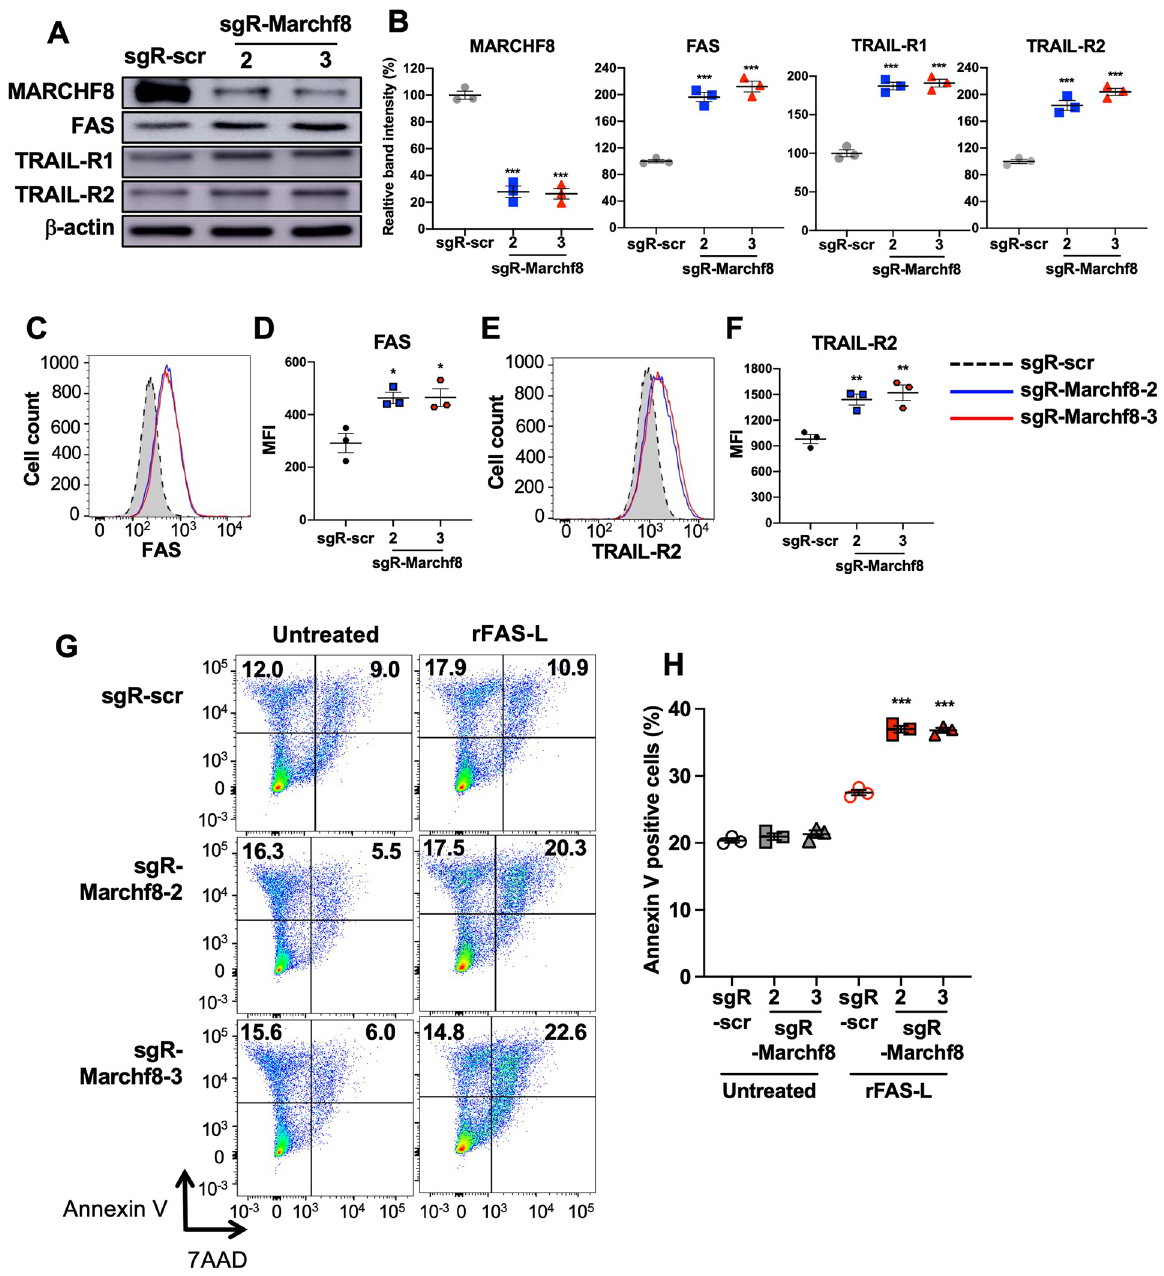
Fig 8. Knockout of Marchf8 expression increases FAS, TRAIL-R1, and TRAIL-R2 protein levels and enhances apoptosis of HPV+ mouse oral cancer cells. mEERL cells were transduced with lentiviral Cas9 and one of two sgRNAs against Marchf8 (sgR-Marchf8-2 and sgR-Marchf8- 3) or scrambled sgRNA (sgR-scr). Protein levels of MARCHF8, FAS, TRAIL-R1, and TRAIL-R2 were determined by western blotting ( A ). Relative band density was quantified using NIH ImageJ ( B ). β -actin was used as a loading control. The data shown are means ± SD of three independent experiments. Cell surface expression of FAS ( C and D ) and TRAIL-R2 ( E and F ) proteins were analyzed by flow cytometry. Mean fluorescence intensities (MFI) of three independent experiments are shown ( D and F ). P values were determined by Student’s t -test. � p < 0.05, �� p < 0.01, ��� p < 0.001. Untreated and rFAS-L-treated mEERL cells ( G ) with sgR-Marchf8-2, sgR-Marchf8-3, or sgR-scr were stained with an anti-annexin V antibody and 7-AAD and analyzed by flow cytometry. The percentage of cells with positive staining is indicated ( G ). The data shown are means ± SD of three independent experiments ( H ). P values were determined by Student’s t -test. ��� p < 0.001.